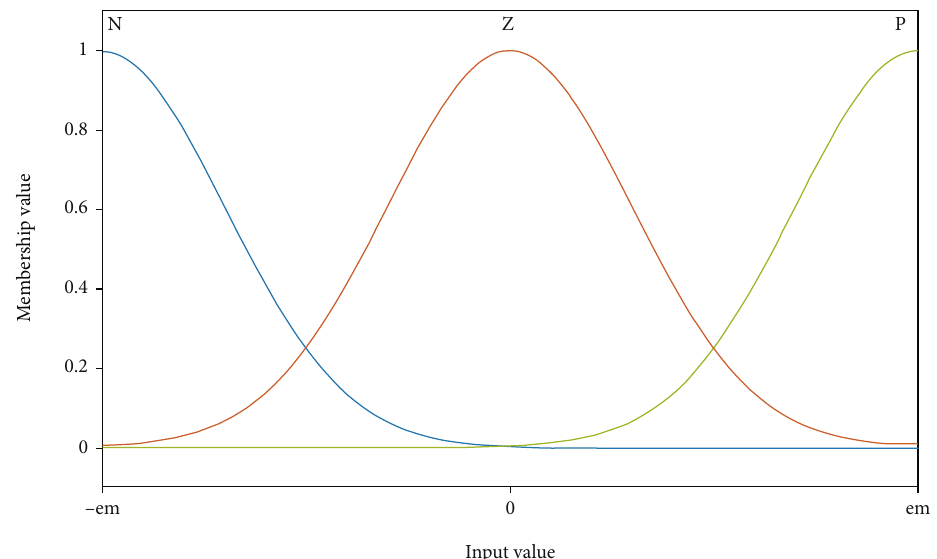
Figure 2: The input membership function of the TSK fuzzy system.